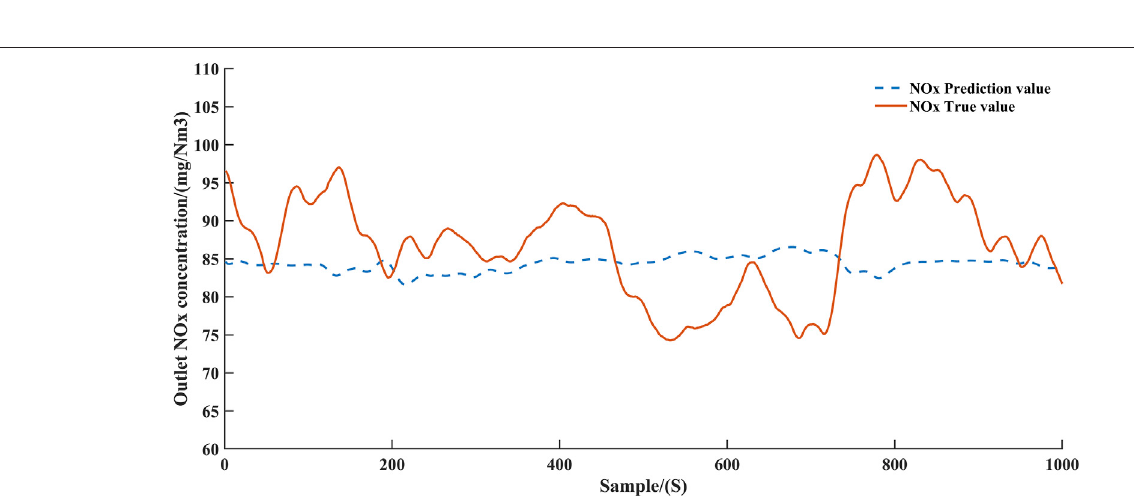
FIGURE 5 | Ammonia concentration prediction curve after parameter freezing training.